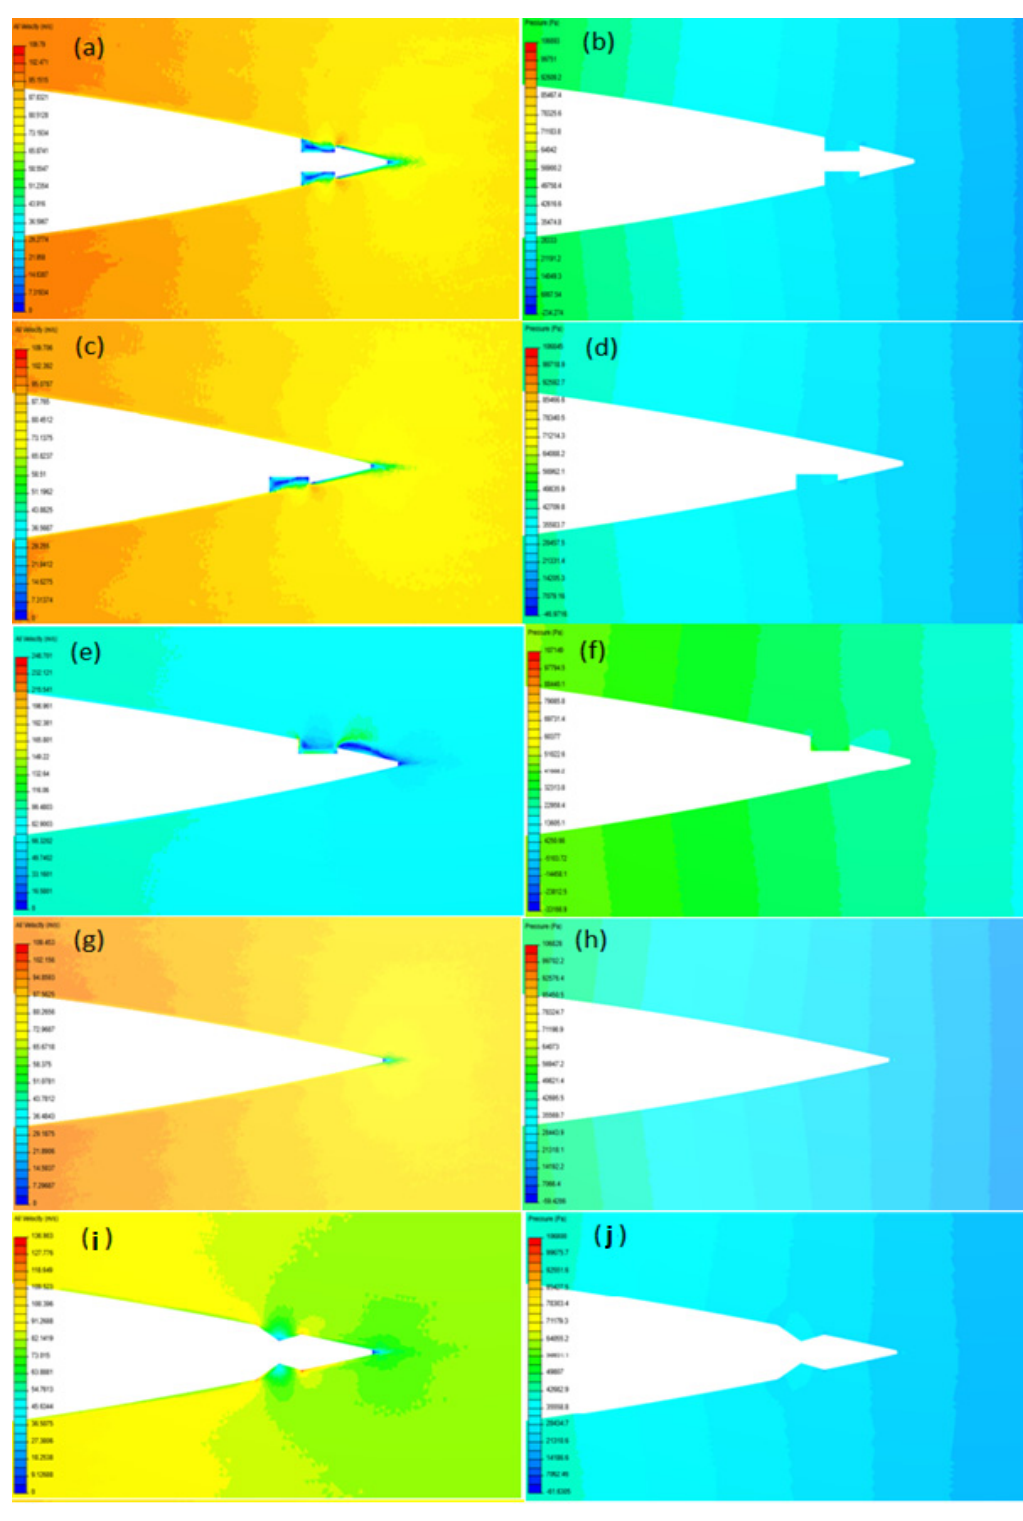
Figure 23. Exploded view showing ( a ) velocity profile on square dimple on both ends, ( b ) pressure profile on square dimple on both ends, ( c ) velocity profile on square bottom dimple, ( d ) pressure profile on square bottom dimple, ( e ) velocity profile on square top dimple, ( f ) pressure profile on square top dimple, ( g ) velocity profile on aerofoil with no dimple, ( h ) pressure profile on aerofoil with no dimple, ( i ) velocity profile on triangle dimple on both ends, and ( j ) pressure profile on triangle dimple on both ends.